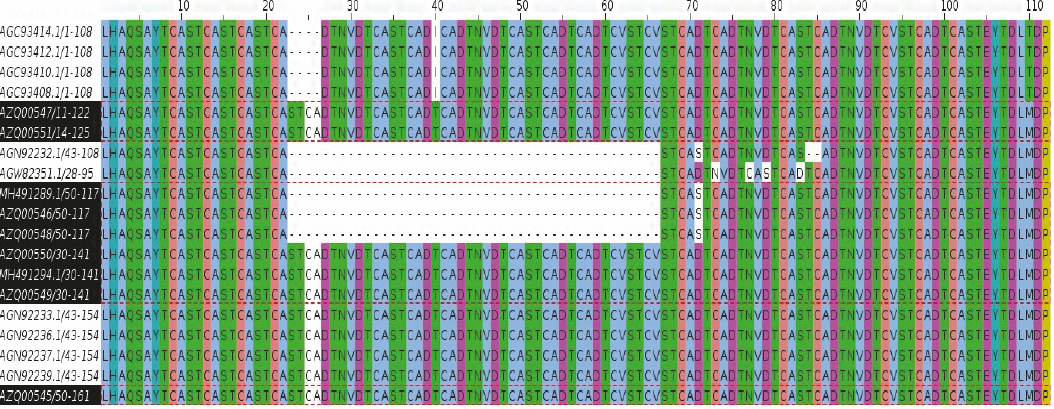
Figure 5: A multiple sequence alignment of the CVR amino acid sequences from this study and previous studies in Uganda and neighboring countries emphasizing tetrameric repeats of representative